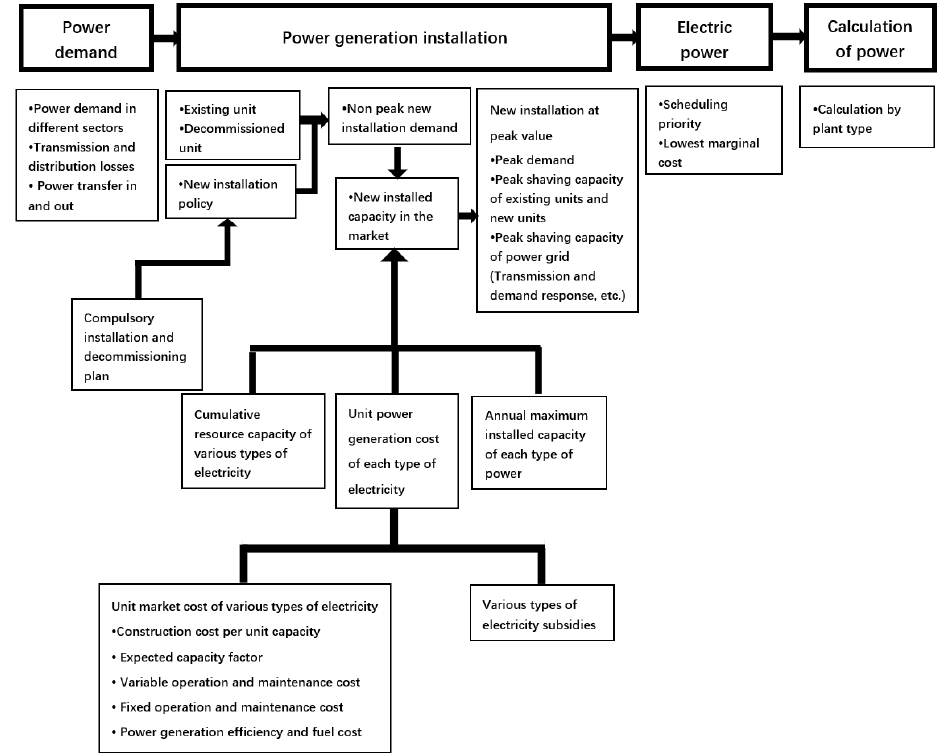
Figure 3. Overview of Power